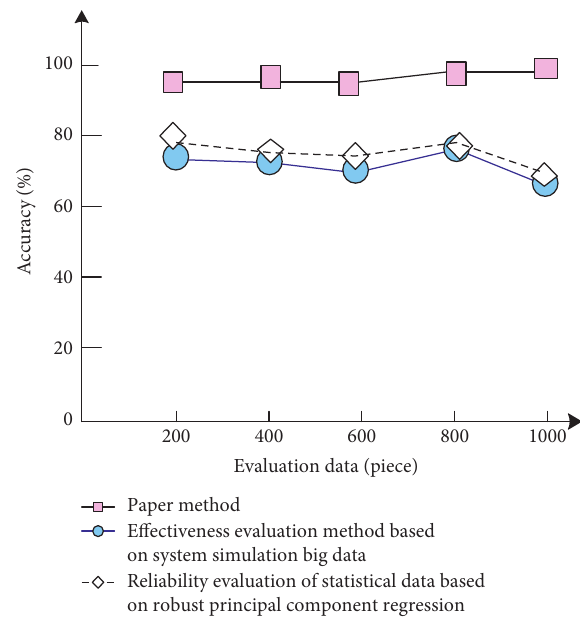
Figure 6: Accuracy analysis of key degree determination of indicators in different